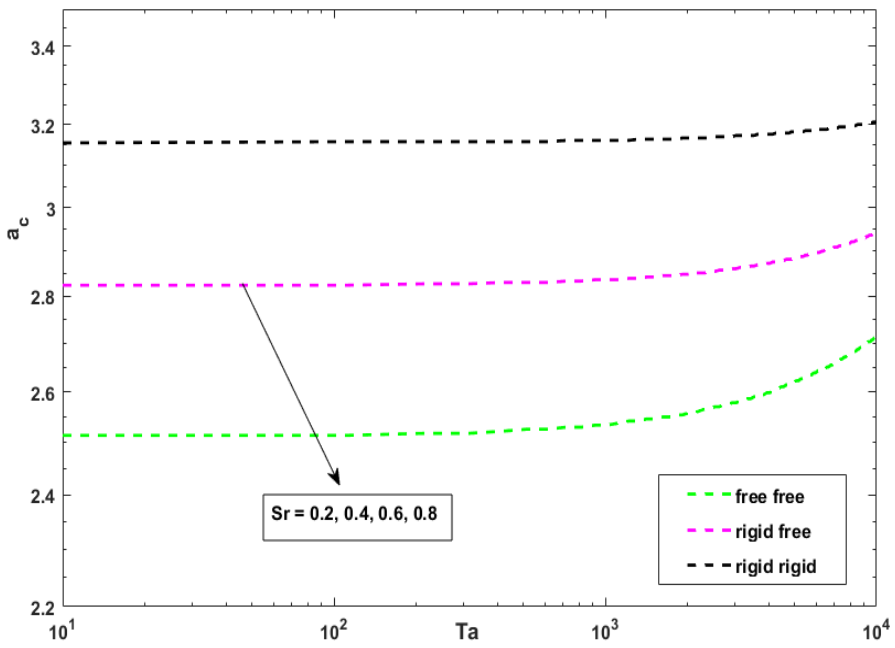
Figure 2. Variation of Ra c with Ta for Da = 0.01, Du = 0.02, Rs = 200, Le = 5,  = 8, M = 0.9, ϕ = 0.9.